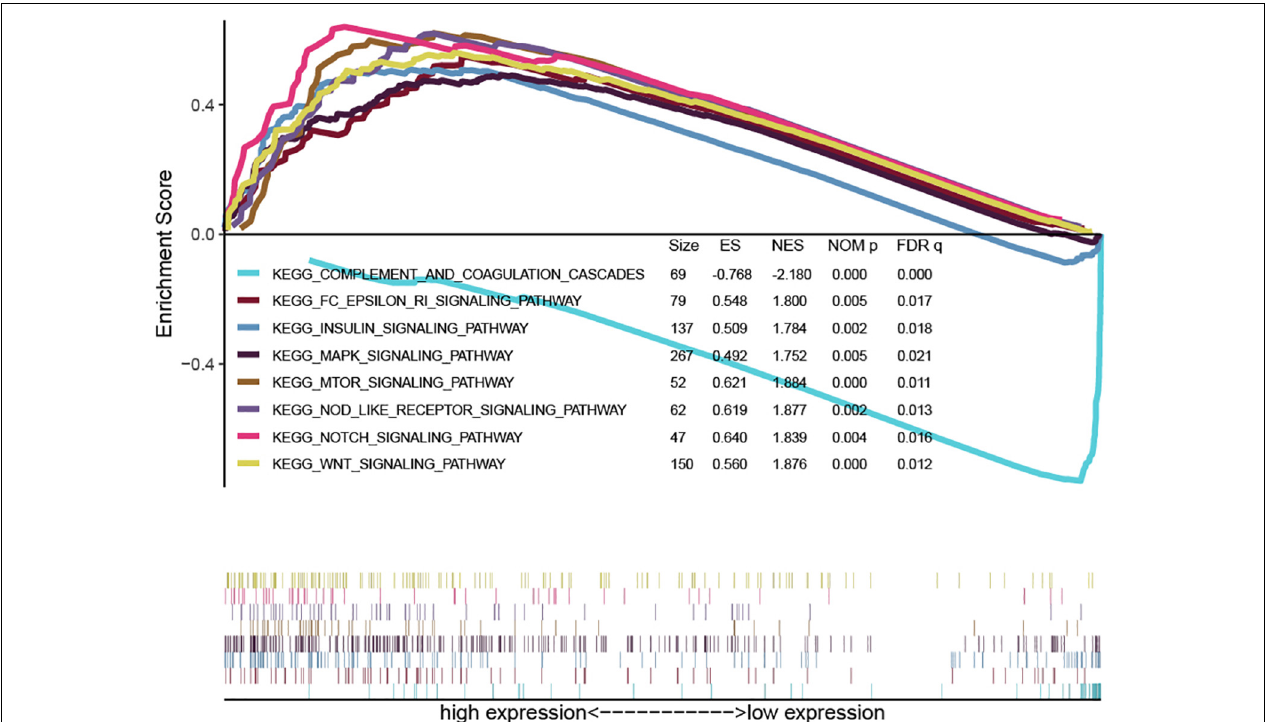
FIGURE 5 | Representative results of the immune-related signaling pathway obtained by Gene Set Enrichment Analysis.